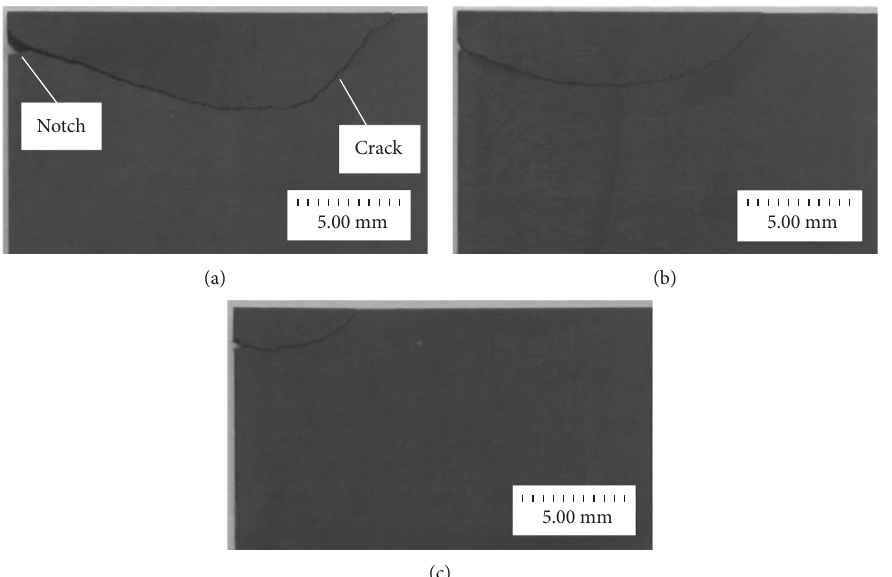
Figure 7: Crack initiation and propagation paths at different rake angles of indenter ( h